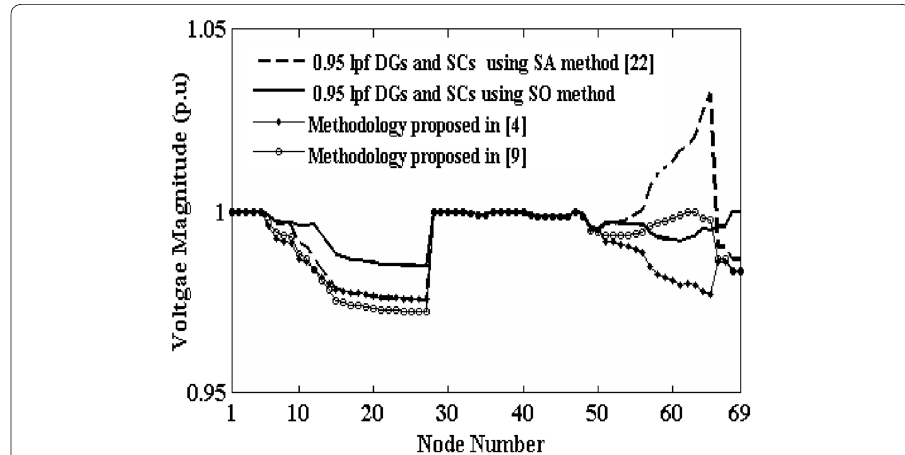
Fig. 9 Voltage profile comparison with methods [4] and [9] for 69-node network